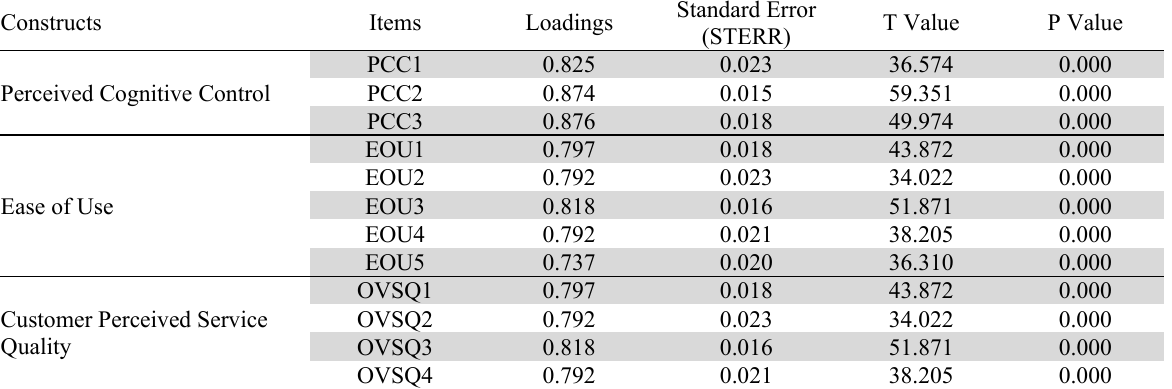
Customer Perceived Service Quality